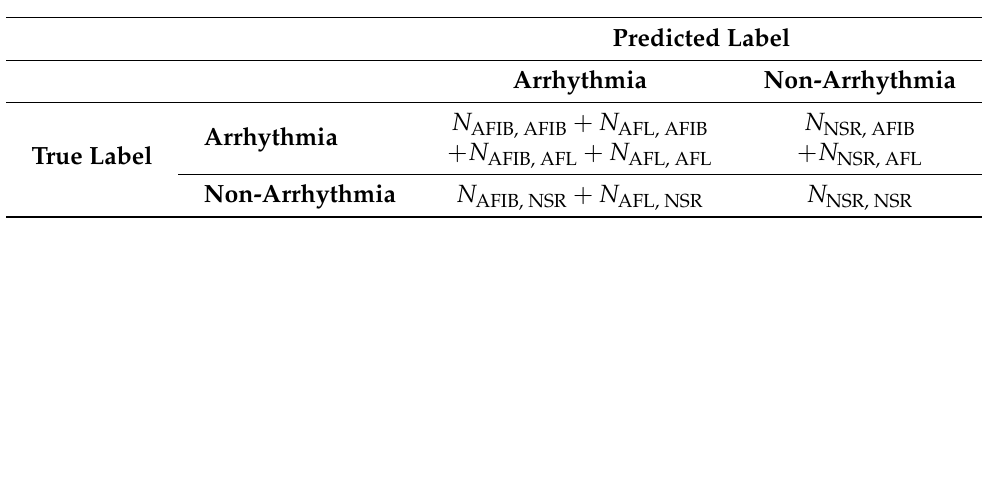
Table 6. The confusion matrix for arrhythmia and